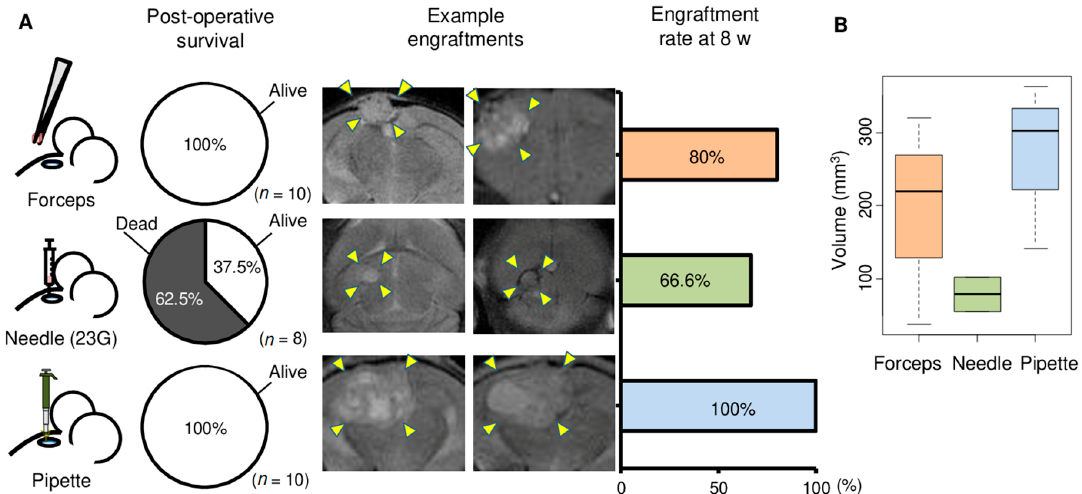
Figure 2. Comparison of three methods for tumor implantation in mouse brain. Brain metastasis of one triple negative breast cancer patient that had been passaged three times as xenograft in mouse brain was used for this experiment. ( A ) Three methods were used for implantation of mouse brain with tumor. The methods used forceps and tissue blocks ( n = 10), 23 G needle and minced tumor tissue ( n = 8), or pipette tip and minced tumor tissue ( n = 10). 1 µL volume of tumor that had been passaged three times as xenograft was used for each mouse. Pie charts depict survival rates within 1 day of implantation with the three methods. Examples of coronal sections of brain in magnetic resonance imaging are shown for two mice each for the three methods. The extent of tumors in the images are indicated with arrowheads. Rates of engraftment of implanted tumor after 8 weeks of surgery for tumor implantation are plotted for the three implantation methods. Mice that did not survive surgery are excluded. ( B ) Tukey boxplots of tumor volumes at 6 weeks in mice with engraftment are shown for the Forceps, Needle, and Pipette methods.